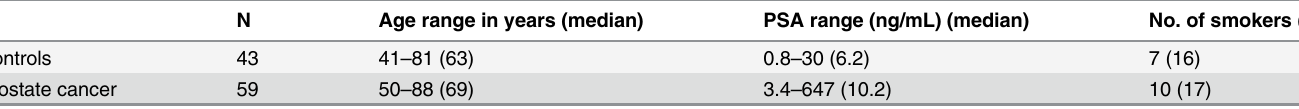
Table 1. Demographics for study participants with and without prostate